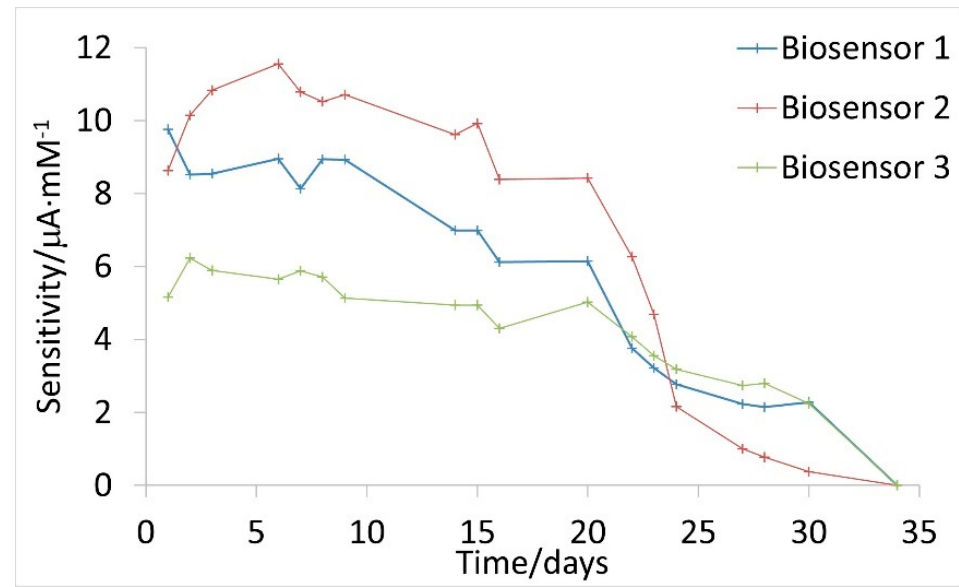
Figure 5. Evaluation of long-term stability for three Ti/TiO 2 NTAs/ppHEMA-co- EGDA/pgPFM/GOx/Chitosan biosensors.